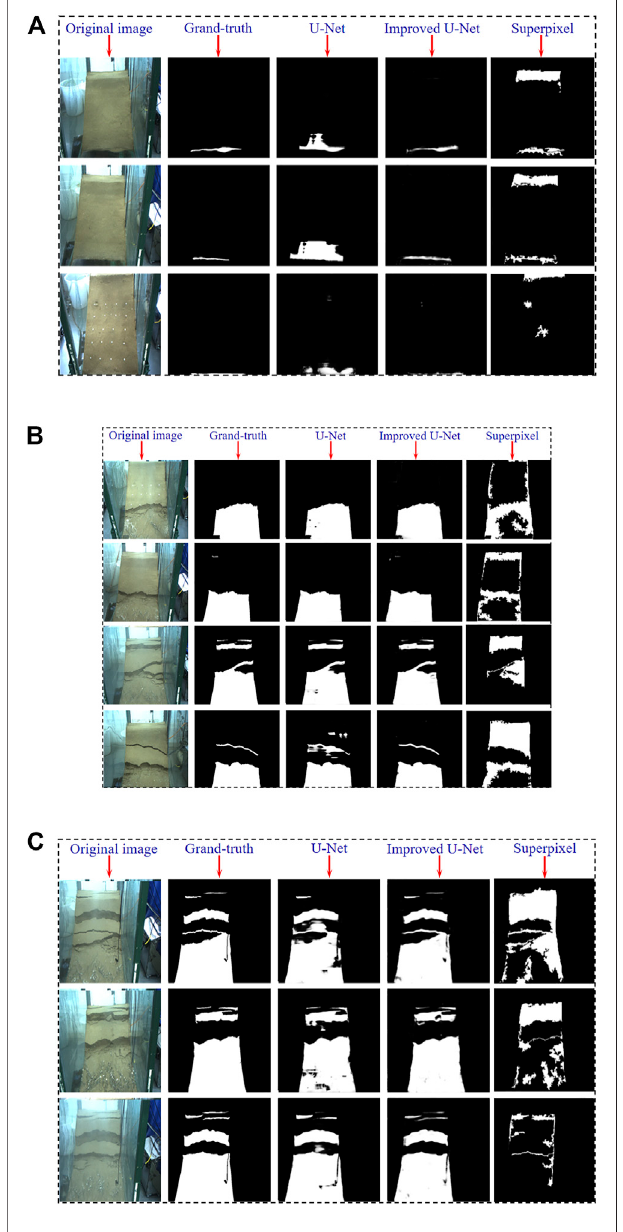
FIGURE 3 | Recognition result graph; (A) Recognition result of small- scale damage; (B) Recognition results in medium-scale damage; (C) Recognition results in large-scale